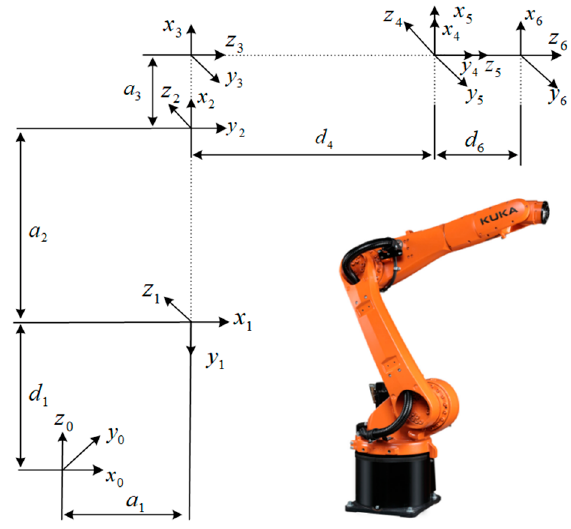
Figure 1. Robot linkage coordinate system.